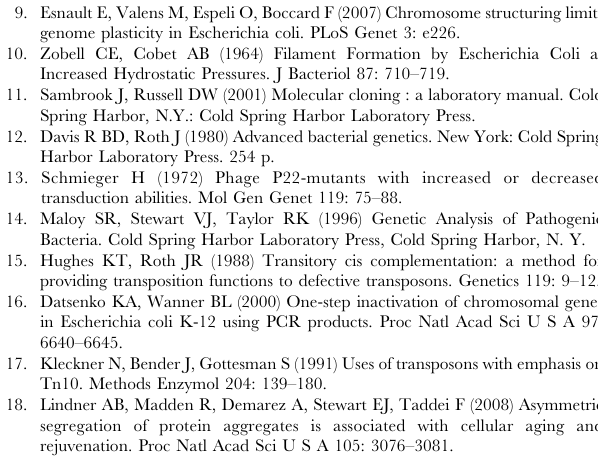
Figure S1 Representative images showing the localiza- tion of the IolR::YFP protein on the DAPI stained nucleoid in LT2 iolR :: yfp cells. Phase-contrast (A), DAPI (B), YFP (C), and merged (D) images are shown. Scale bar corresponds to 5 m m. Figure S2 Growth curves of LT2 wild-type, LT2 iscR ::- Mu d Y and LT2 iscR :: yfp ., with growth monitored as an increase in optical density (OD 630 nm ) in time. Mean values of 3 independent experiments are shown, with standard deviations being , 11%. (TIF) Figure S3 Growth curves of LT2 wild-type and LT2 iscR :: yfp-frt-cat-frt , with growth monitored as an in- crease in optical density (OD 630 nm ) in time. Mean values of three independent experiments are shown, with standard deviations being , 8%.